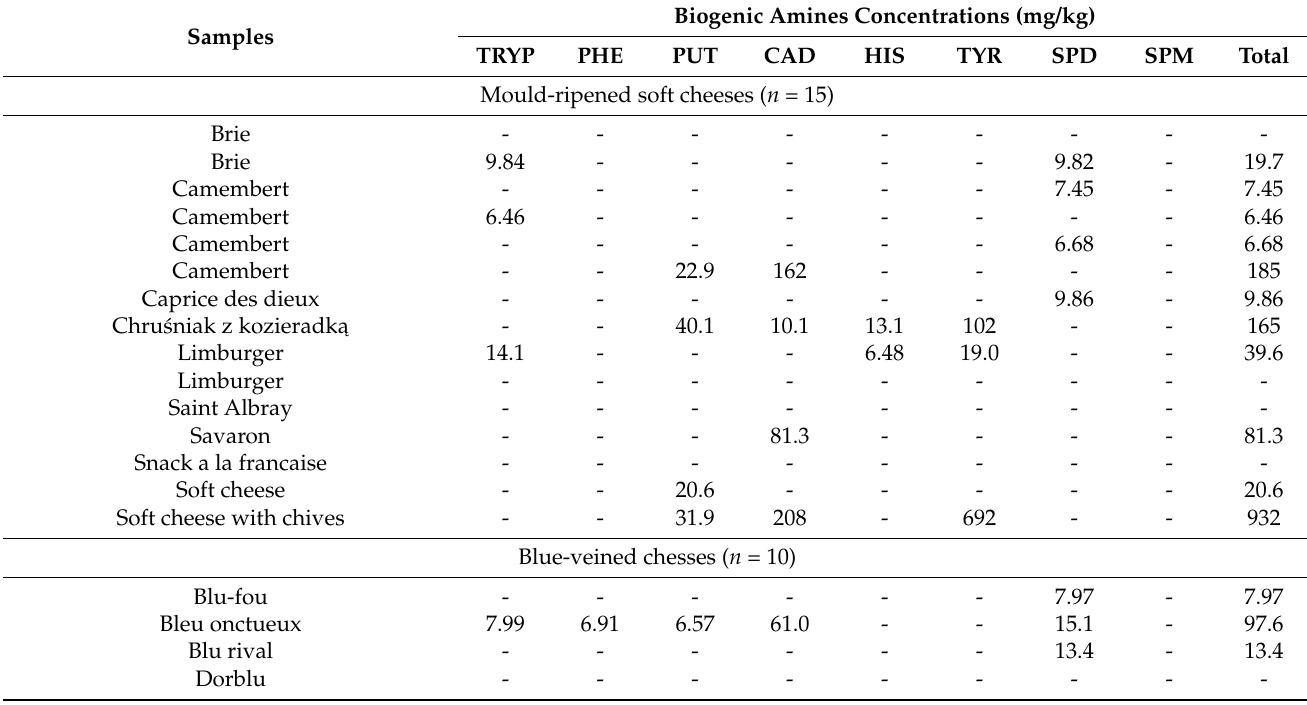
Table 5. The content of biogenic amines (TRYP—tryptamine, PHE—2-phenylethylamine, PUT—putrescine, CAD—cadaverine, HIS—histamine, TYR—tyramine, SPD—spermidine, SPM—spermine) deter- mined in different ripened cheese